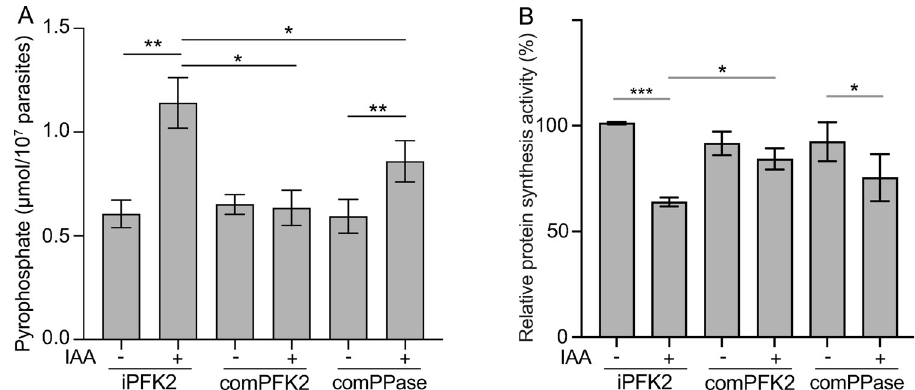
Fig 6. PFK2 depletion causes PPi accumulation and reduced protein synthesis. A : The pyrophosphate concentration in the indicated parasites with or without IAA treatment for 6 hours. Means ± SEM of four independent experiments, � P < 0.05, �� P < 0.01, paired Student’s t test. B : Nascent protein synthesis rates in the indicated strains with or without 6 hours of IAA pretreatment. Means ± SEM of five independent experiments, � P < 0.05, ��� P < 0.001, paired Student’s t test. Details for the statistical analyses are provided in S3